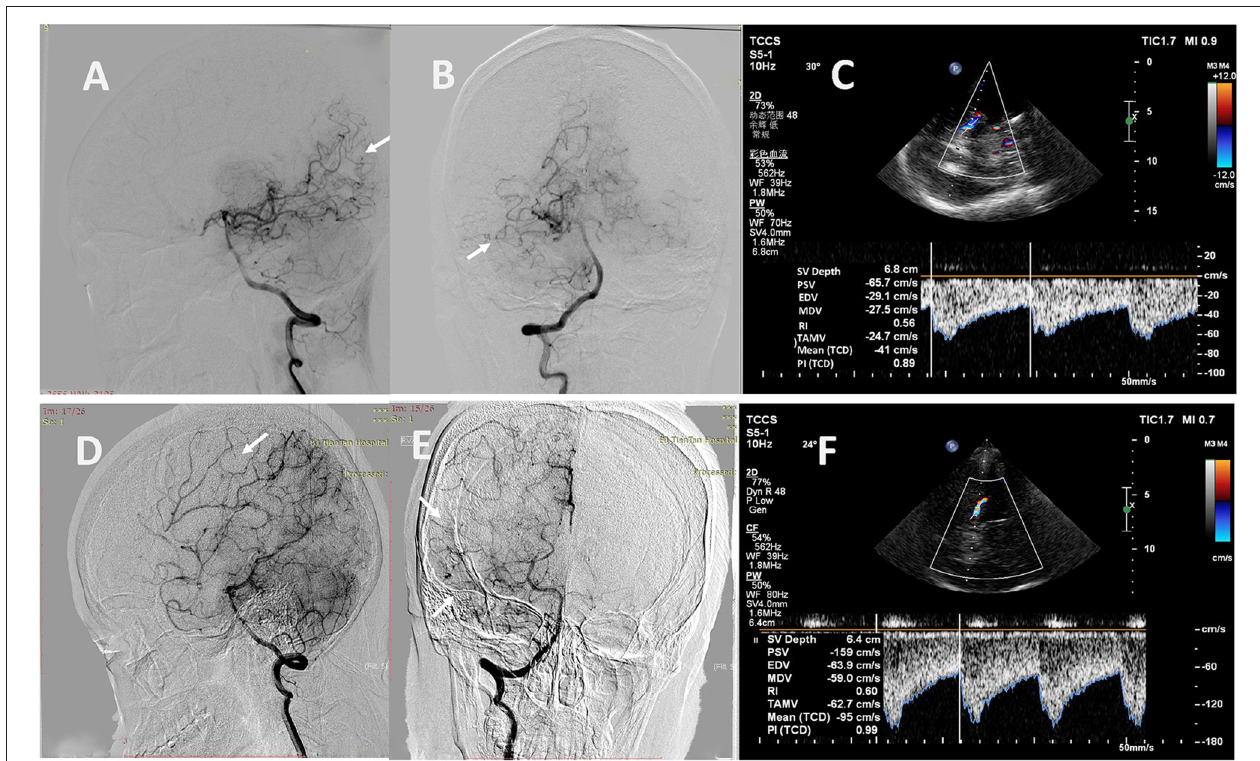
FIGURE 5 | Representative cases. (A, B) A 24-year-old man with MMD scored 2 points in the leptomeningeal system on the right (white arrows). (C) The TCCS showed low values of PSV (66 cm/s) and EDV (29 cm/s) in the right PCA. (D, E) A 33-year-old woman with MMD scored 5 points in the leptomeningeal system on the right (white arrows). (F) The TCCS showed high values of PSV (159 cm/s) and EDV (64 cm/s) in the right PCA. MMD, moyamoya disease; TCCS, transcranial color-coded duplex sonography; PSV, peak systolic velocity; EDV, end diastolic velocity; PCA, posterior cerebral artery.